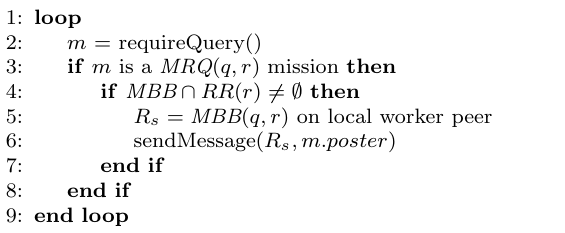
Algorithm 5 Subscribing WP